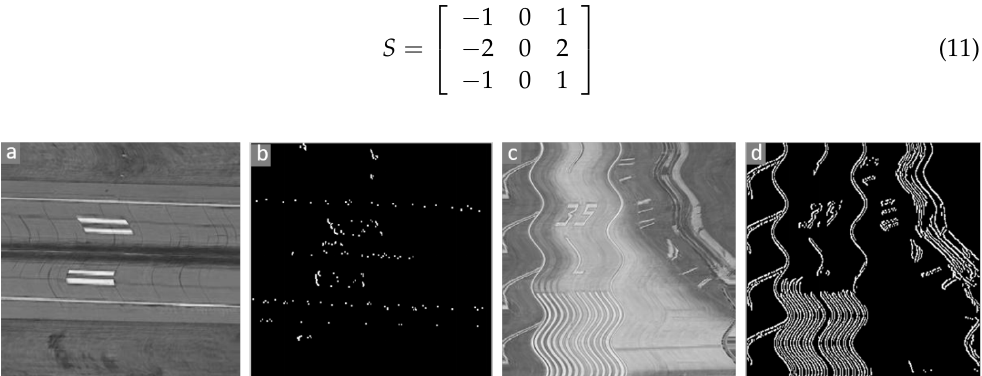
Figure 5. Edge detection by the Sobel operator in the vertical direction. ( a ): An example deformed image with horizontal features; ( b ): Edge detection result of ( a ); ( c ): An example deformed image with vertical features; ( d ): Edge detection result of ( d